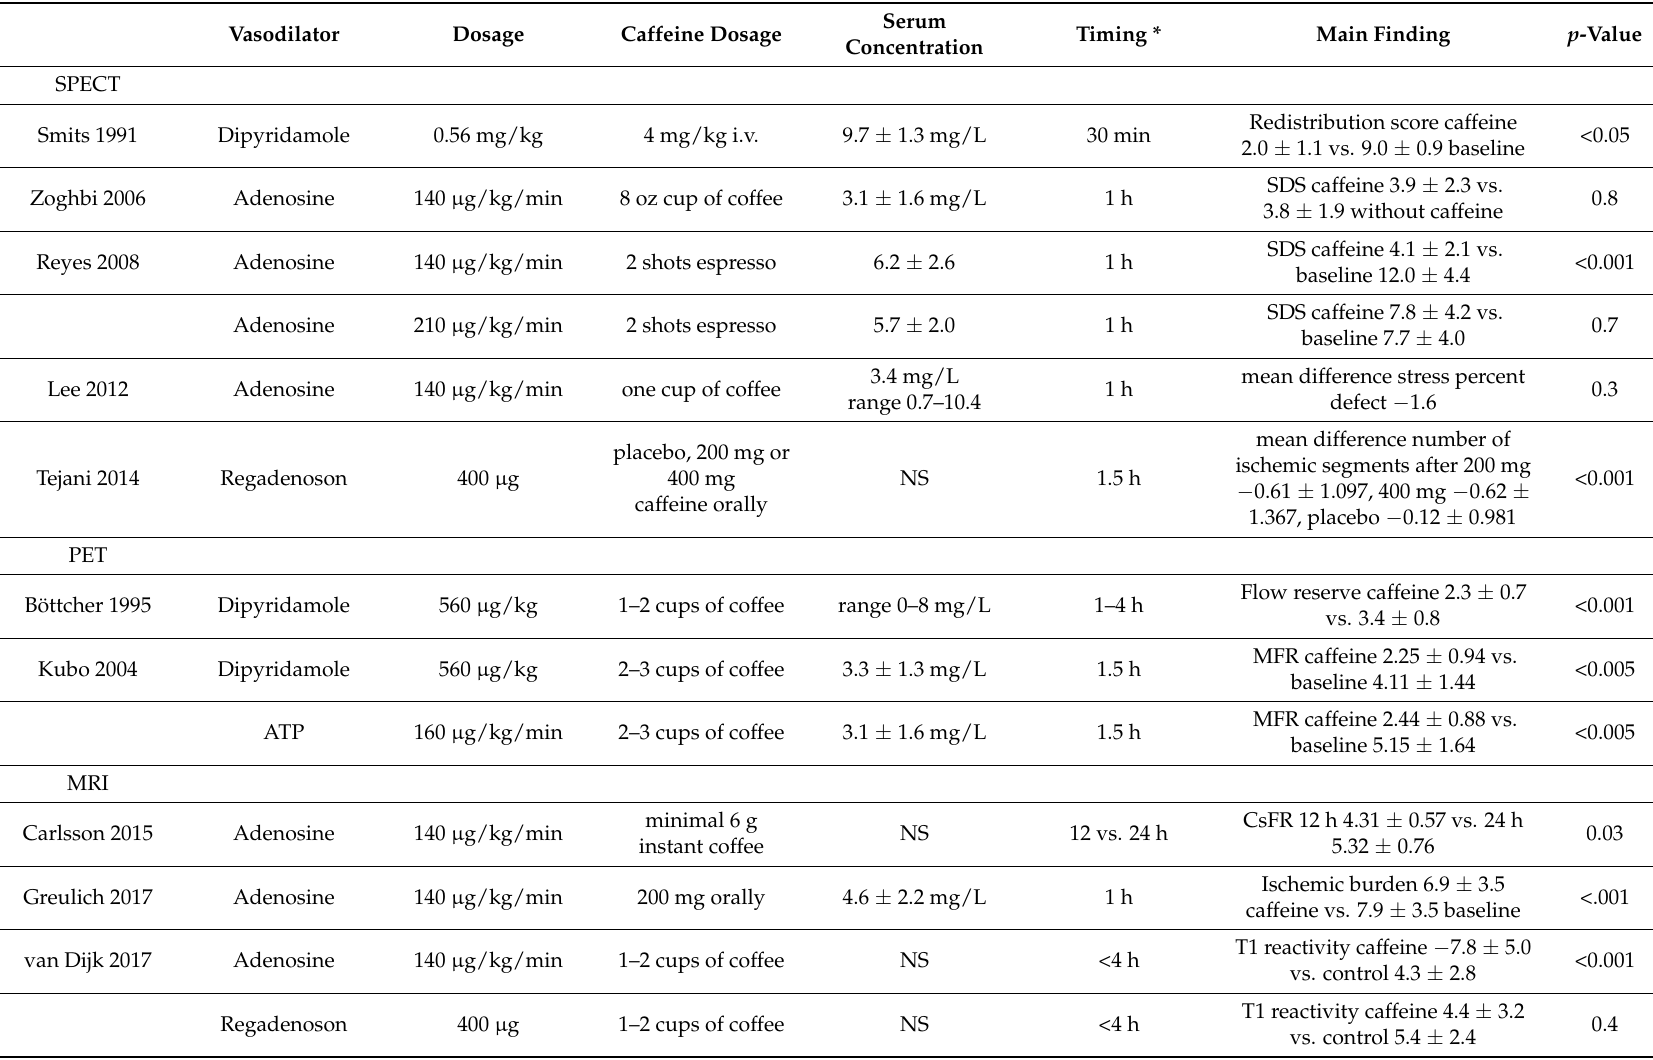
Table 2. Study design details concerning vasodilator agent, caffeine, and main findings. * Timing of caffeine intervention prior to the examination. Continuous variables either reported as mean ± standard deviation or median (interquartile